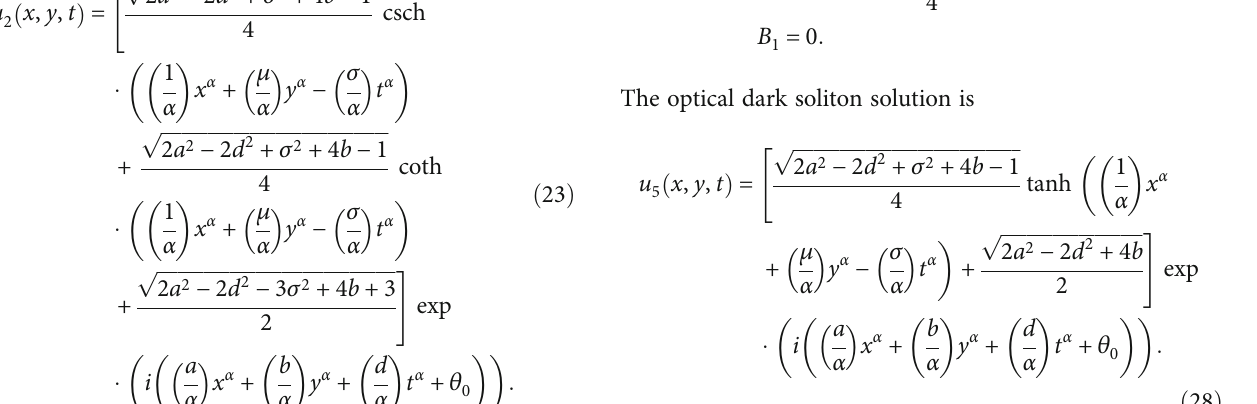
p ffiffiffiffiffiffiffiffiffiffiffiffiffiffiffiffiffiffiffiffiffiffiffiffiffiffiffiffi 2 a 2 − 2 d 2 + 4 b